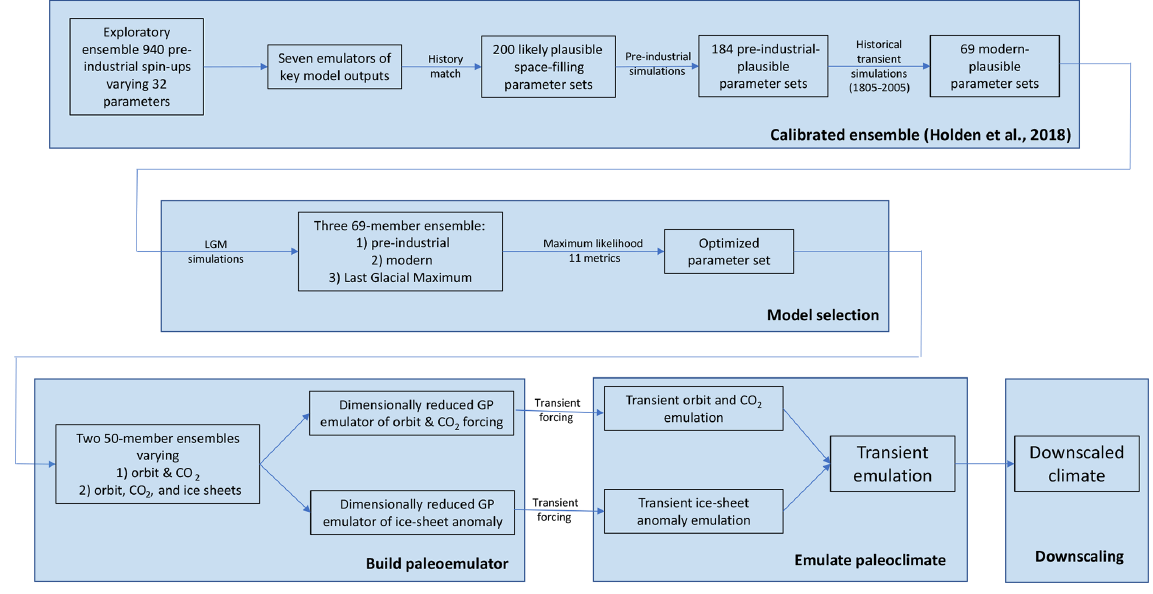
Figure 1. Schematic of experimental